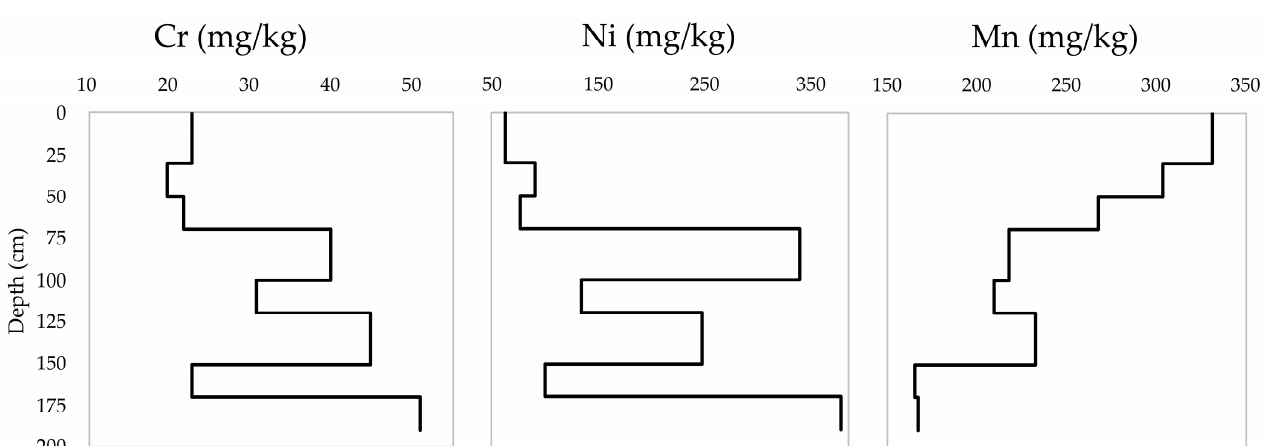
Table 3. Correlation analysis results (statistically significant marked red, α = 0.05).